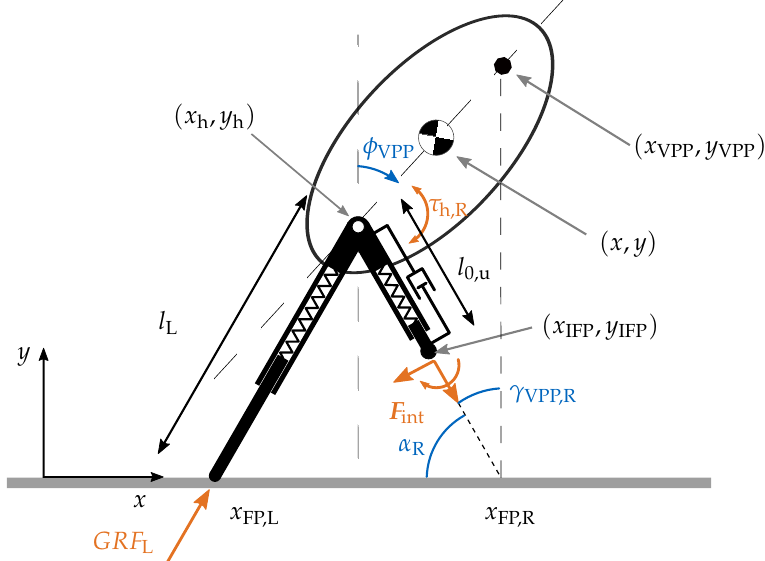
Figure 4. Model of the amputee based on the VPP model. The right leg is cut, and a point mass m IFP is added to serve as an interface point between the simulation and experimental system. A damper between the hip and point mass is added to reduce oscillations. The resting leg length of the remaining upper part of the right leg is l 0,u . At the interface point ( x IFP , y IFP ), the measured forces/torque F int act on the model. Figure adapted from [23] (reprinted with permission from [23], 2020